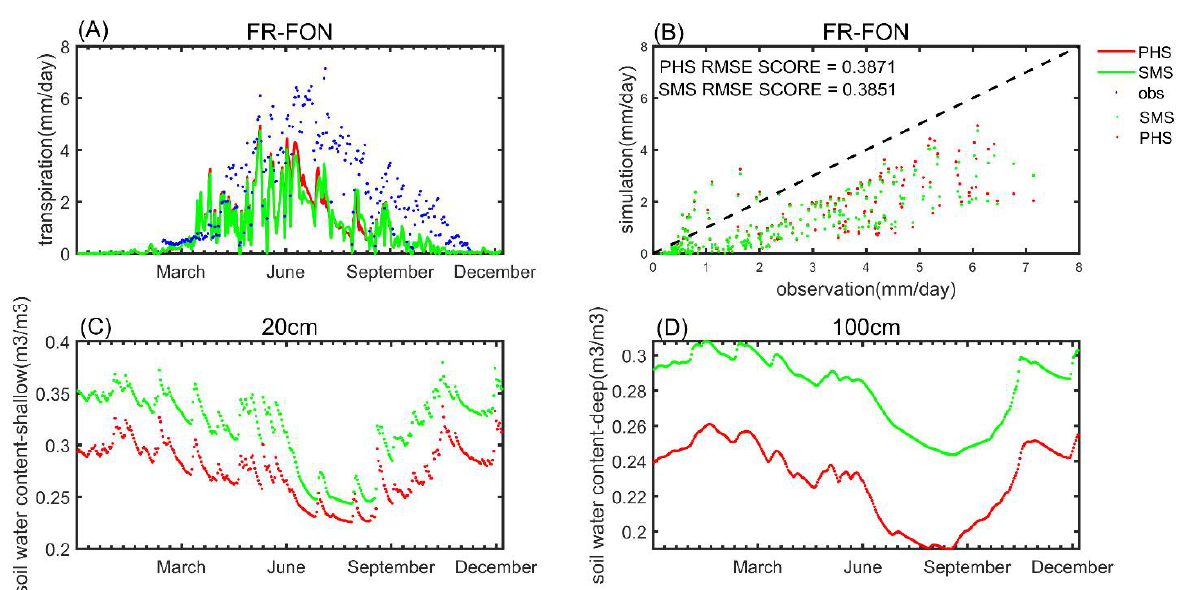
Figure 6. Transpiration (mm/day) and soil water content (m 3 /m 3 ) at FR-FON (the site name) in 2013. ( A ) seasonal variation Forests 2021 , 12 , x FOR PEER REVIEW